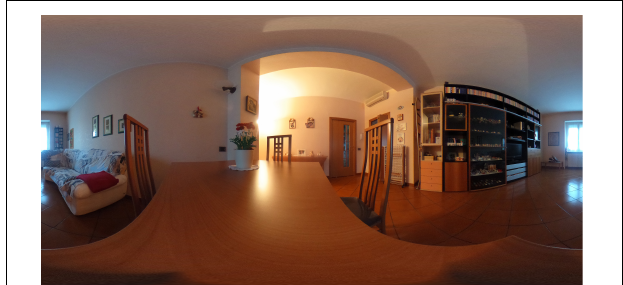
FIGURE 2 | An example of a 360 ◦ daily home environment implemented in EXIT 360 ◦